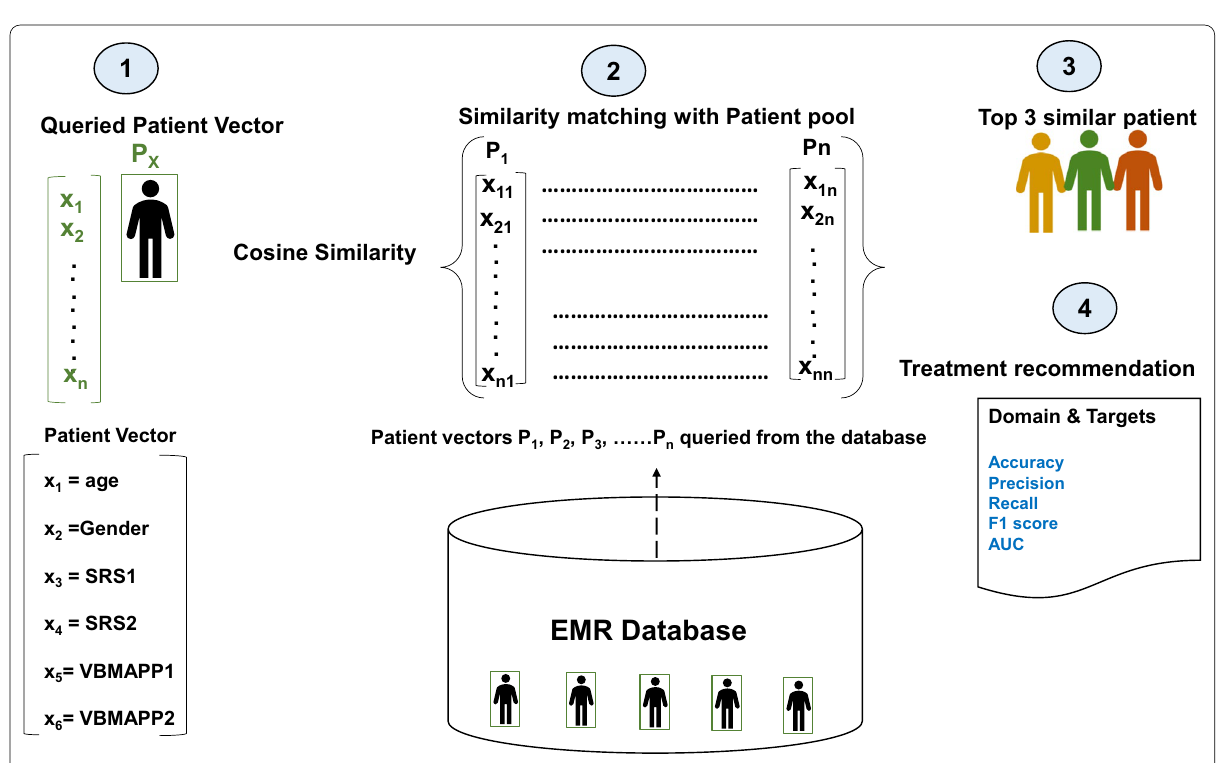
Fig. 1 Patient similarity